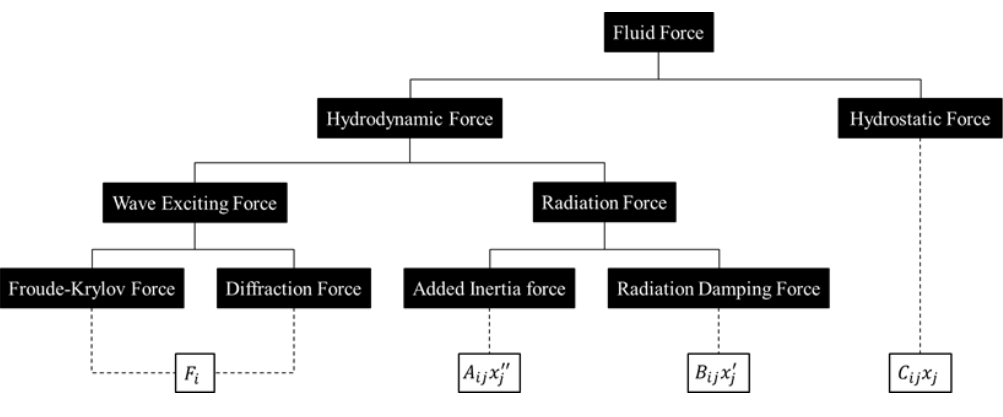
Figure 6. Components of fluid force.